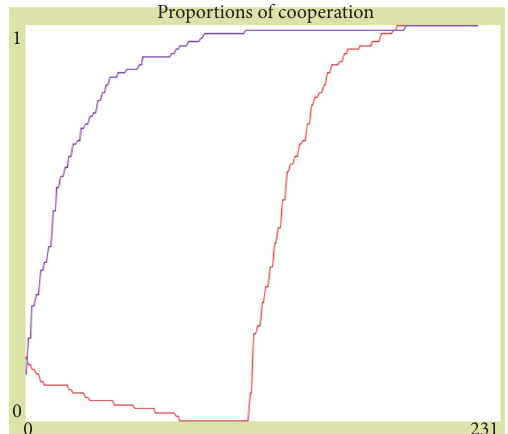
Figure 5: Influence of increasing enterprise observation capability on